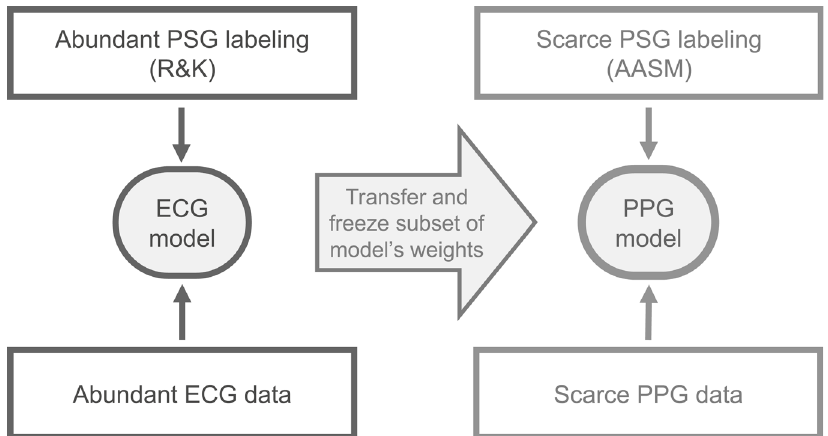
Fig. 2 Transfer learning. The source model (ECG model) is trained using ECG data and PSG based labels scored according to the R&K rules (Siesta data set in this work) and then its knowledge is transferred to learn a new task, involving PPG input data and PSG annotation according to the AASM rules (Eindhoven data set in this work), resulting in the PPG